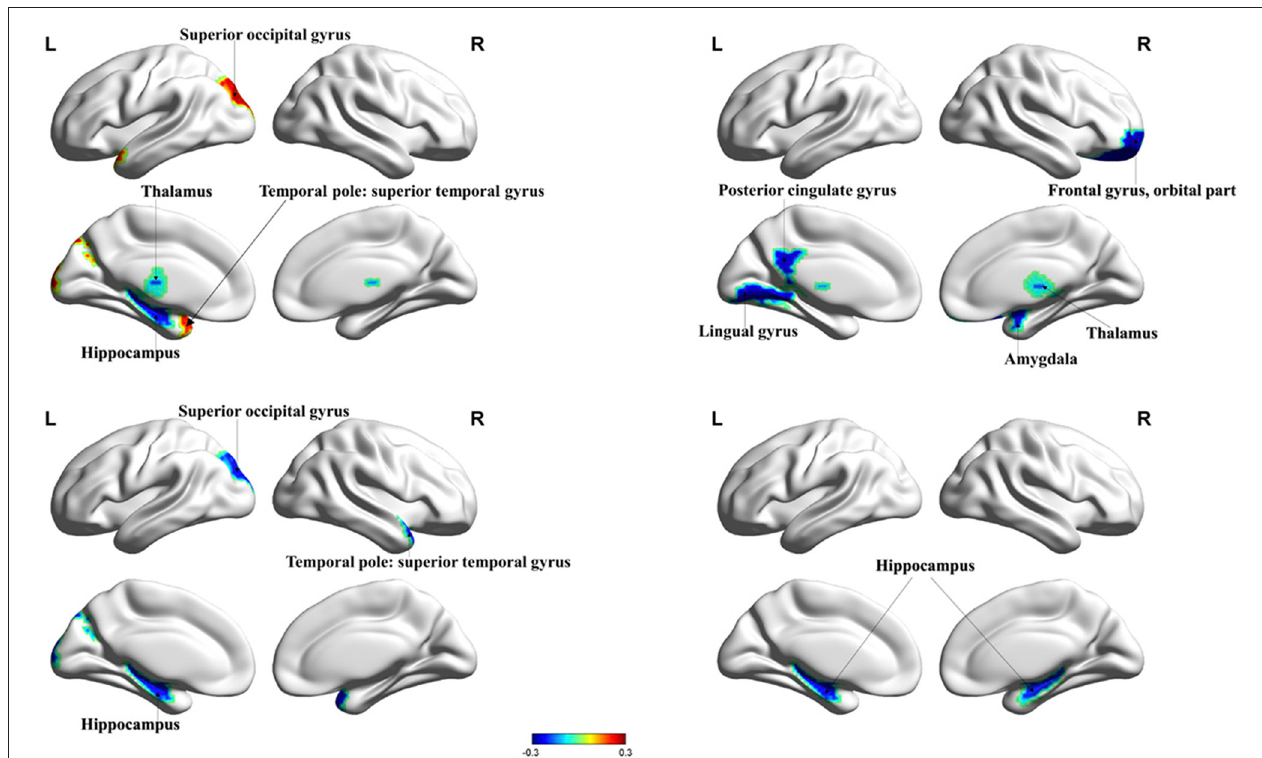
FIGURE 2 | Significant changes in the nodal properties ( P < 0.05) within different brain regions between the ANI and non-HAND groups are projected onto both hemispheres of the brain and over a range of thresholds, as shown. Hot colors represent brain regions with increased nodal properties, whereas cool colors represent decreased nodal properties. The betweenness centrality was significantly decreased in the hippocampus and thalamus and significantly increased in superior occipital gyrus and temporal pole: superior temporal gyrus. The degree of centrality was significantly decreased in the lingual gyrus, posterior cingulate gyrus, frontal gyrus, orbital part, amygdala, and thalamus. The nodal cluster coefficient was significantly decreased in the superior occipital gyrus, temporal pole: superior temporal gyrus, and hippocampus. Nodal efficiency in the hippocampus was significantly decreased. BC, betweenness centrality; DC, degree centrality; NCE, nodal cluster coefficient; NE, nodal